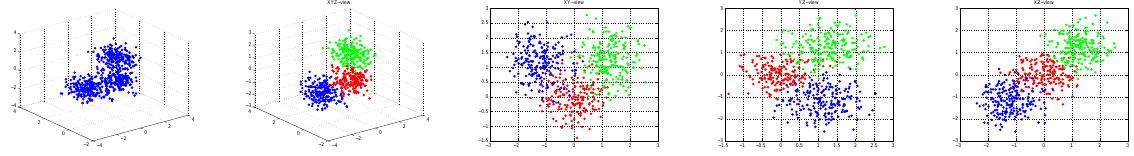
Figure 4: Clustering results of the proposed method on the uniformly distribution test data.